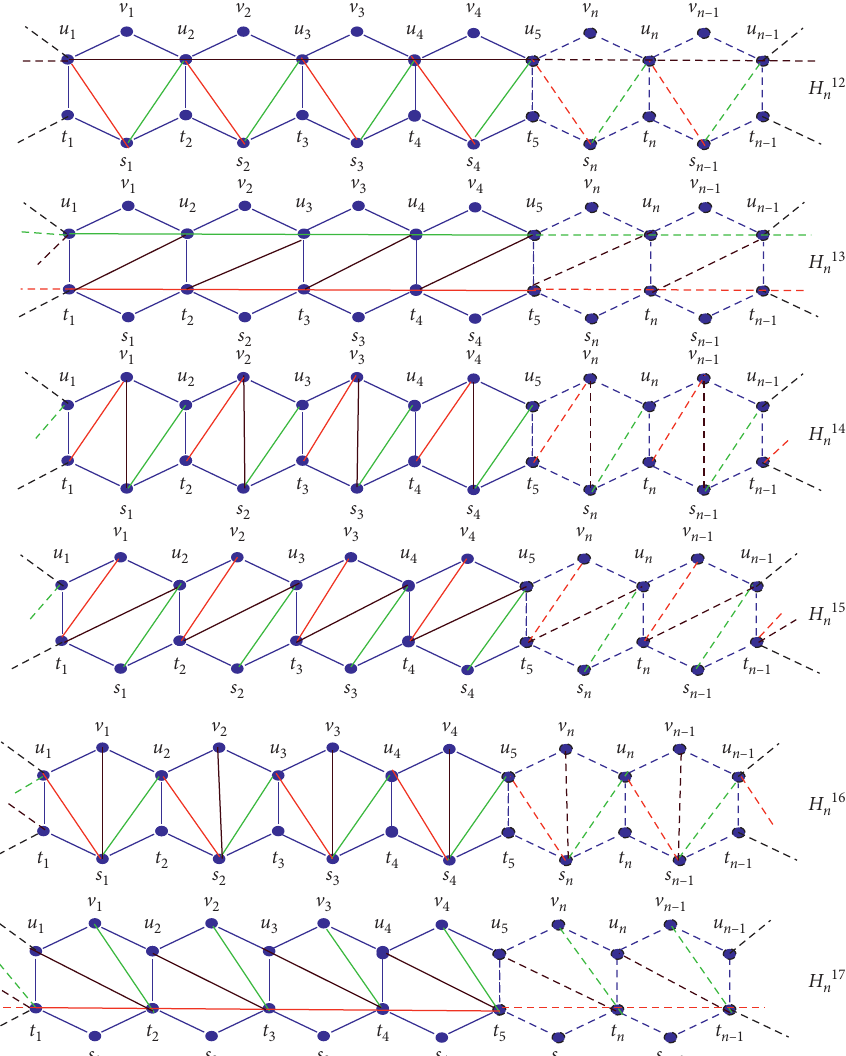
Figure 5: Rotationally symmetric hexagonal planar graphs with 5